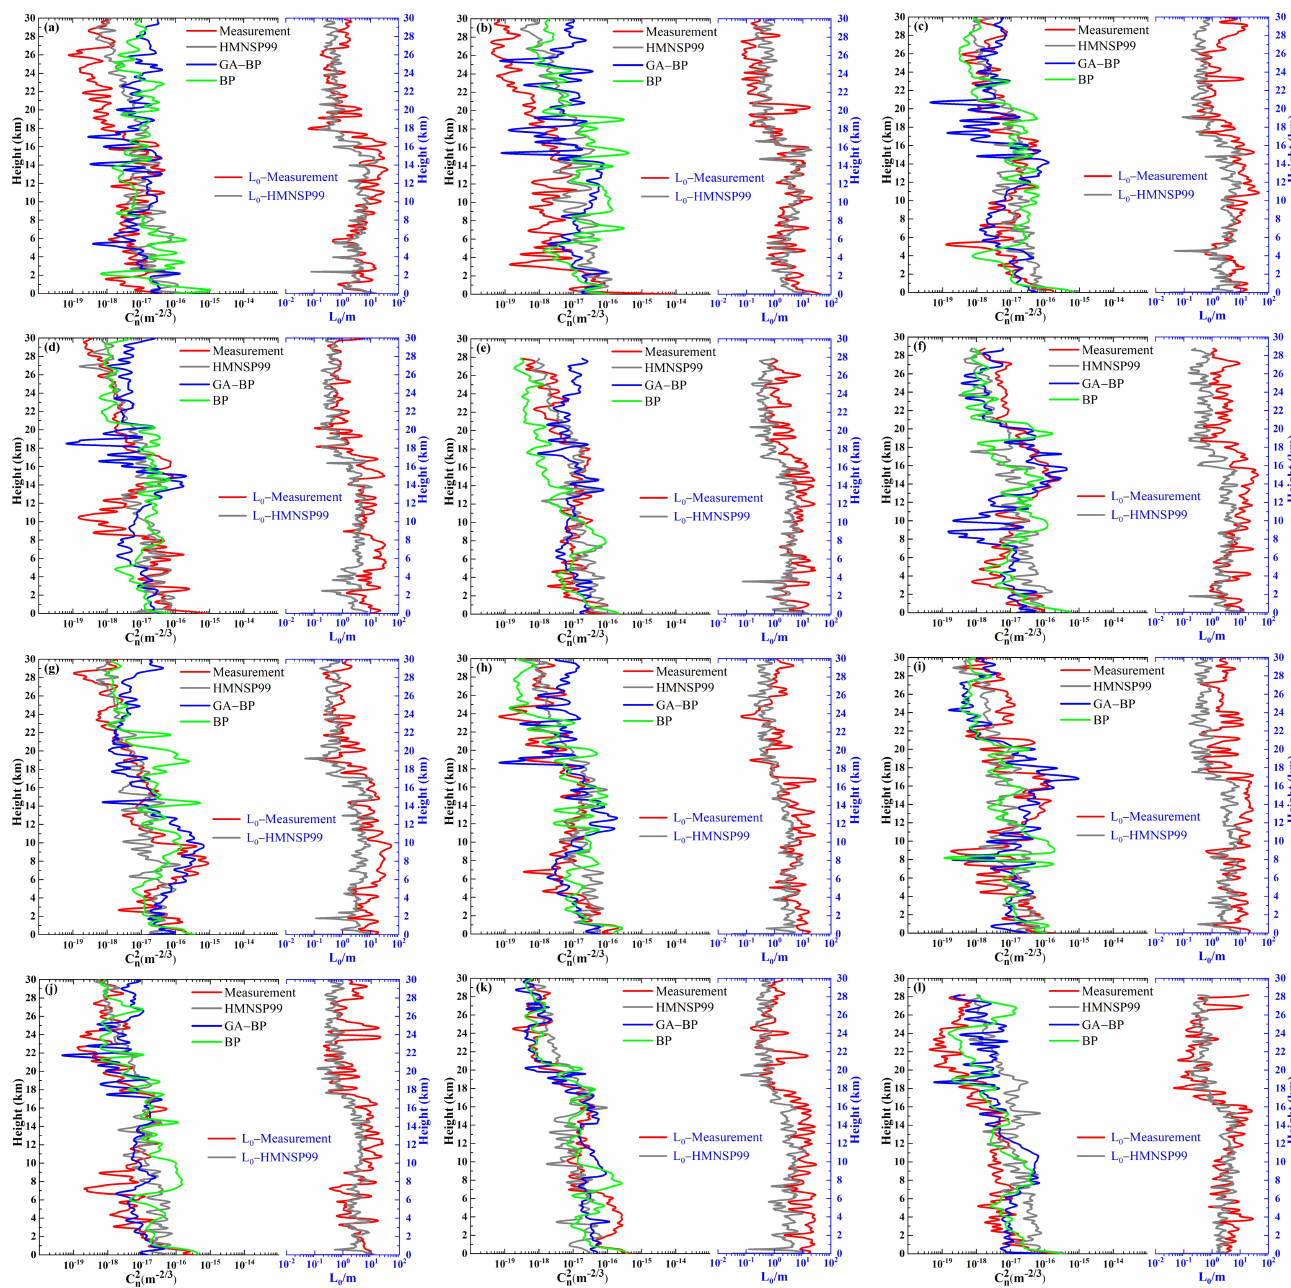
Figure 8. ( a – l ) Comparison of the C 2 n ( h ) profiles (left) between the models (GA-BP, BP and HMNSP99) and the measurement, the L 0 ( h ) profiles (right) from the HMNSP99 model and the measurement in the